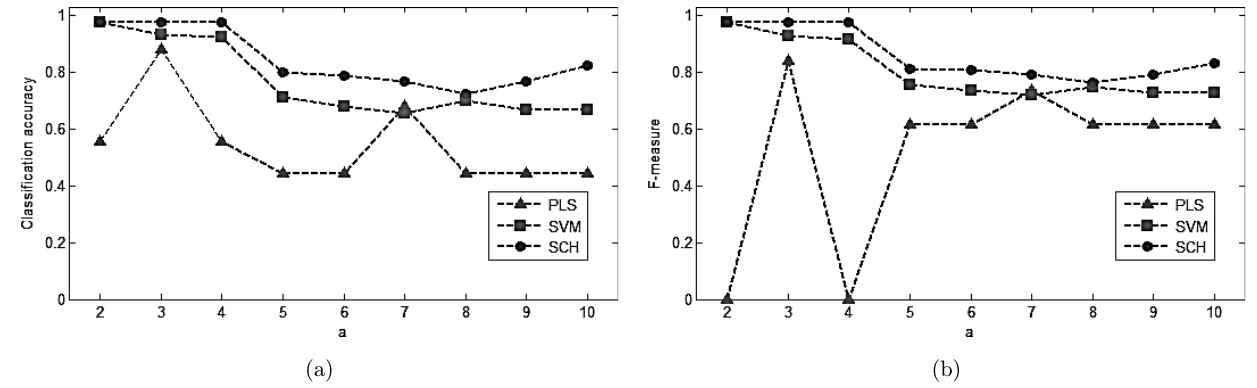
Fig. 9. The classi¯cation accuracy for the active substance on pharmaceutical tablets